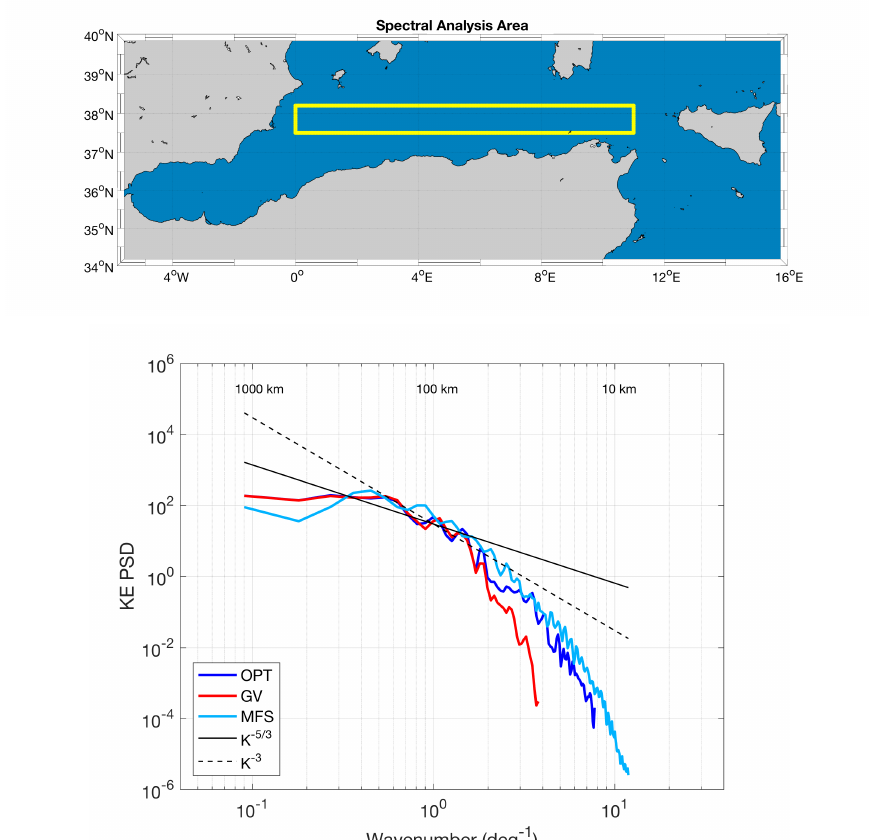
Figure 13. Optimal (blue line), altimeter-derived (red line) and MFS (light blue line) kinetic energy spatial spectra. The mean spectra are computed in the area delimited by the yellow box (top panel). The black continuous and dashed lines represent the surface and internal predictions of the QG turbulence, respectively. The spectra are computed on the date of 23 July 2016 and are represented as a function of the spatial wavenumber.